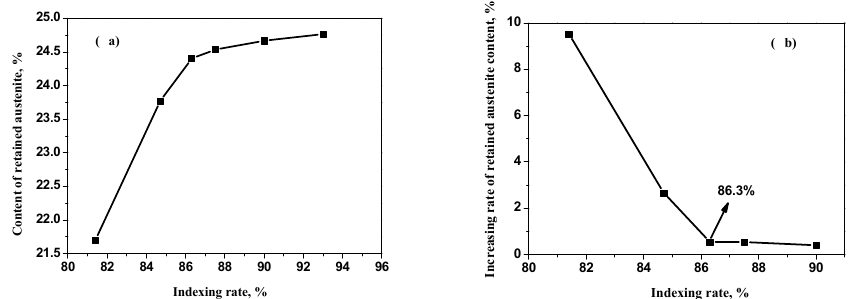
Figure 2. Curves of the measured retained austenite content ( a ) in TRIP780 steel and its increasing rate ( b ) with indexing rate.